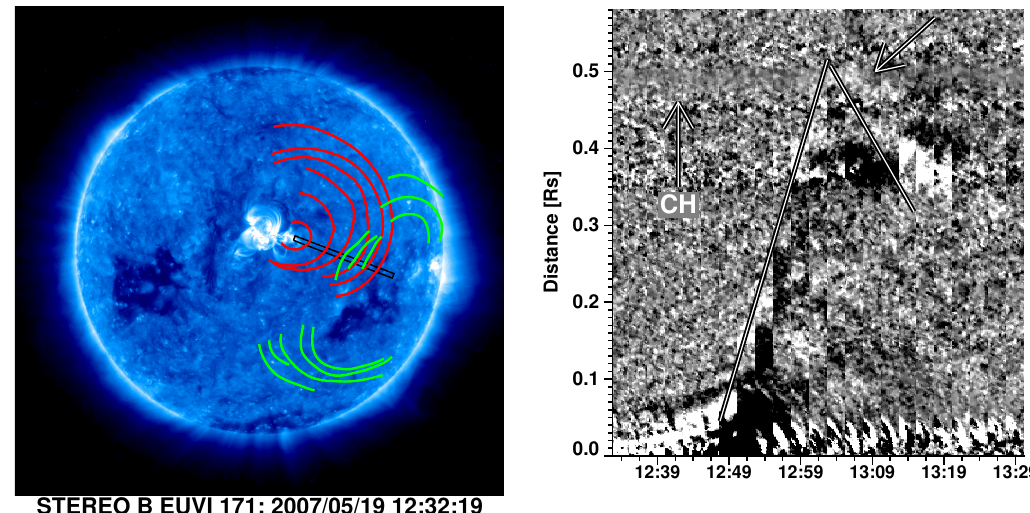
Figure 30: The first observed reflection of a coronal wave at a coronal hole boundary. Left : STEREO/EUVI image with overplotted wavefronts of the primary wave ( red ) and the reflected waves ( green ). Right : Distance-time intensity plot made from stacking EUVI difference images within the rectan- gular slit shown on the left panel. Note the reflection around 13:00 UT. Image reproduced with permission from Gopalswamy et al. (2009), copyright by